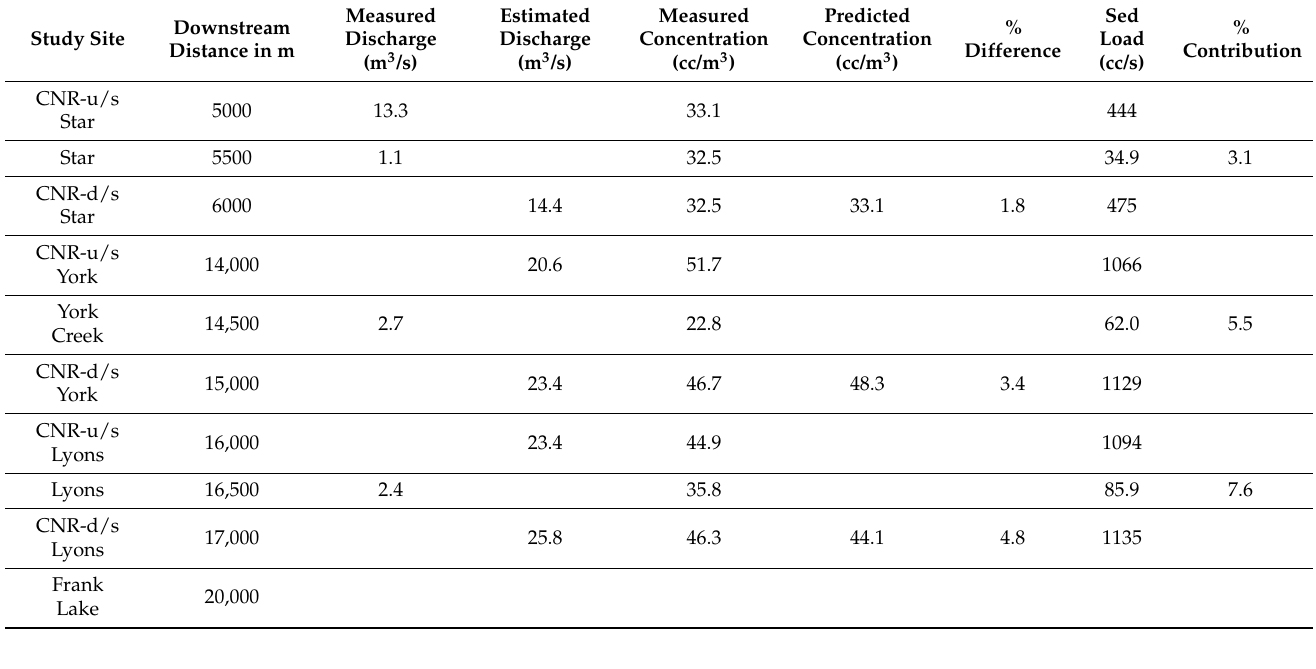
Table 3. Summary of suspended sediment measurements in the upper Crowsnest River (CNR) and tributaries (June 2015). Study sites relate to those shown in the schematic in Figure 6.